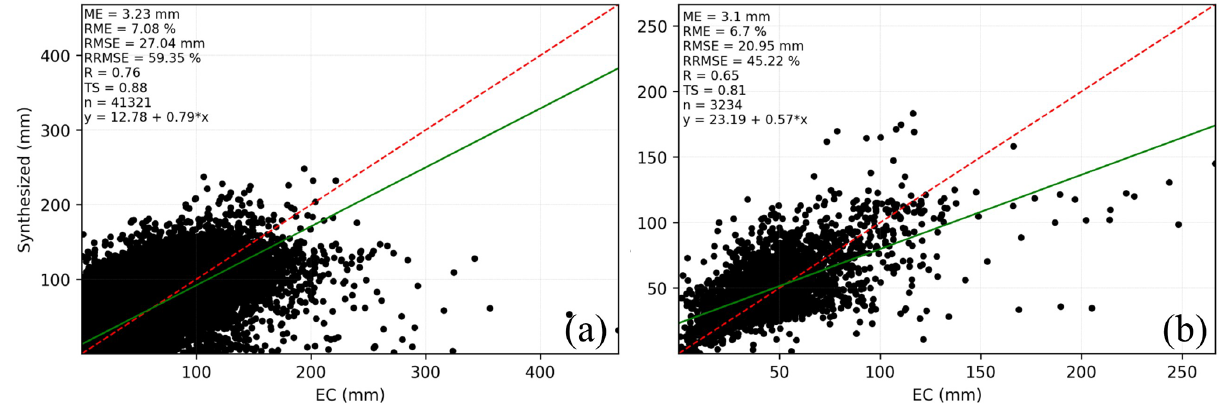
https://doi.org/10.5194/essd-13-447-2021 Earth Syst. Sci. Data, 13, 447–480,